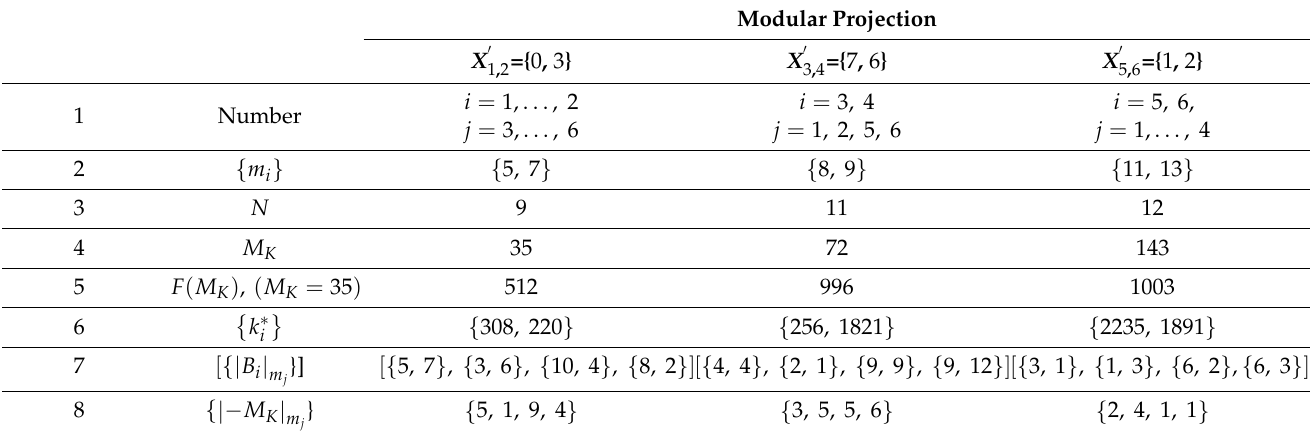
Table A5. Pre-computed constants for each modular projection. Modular